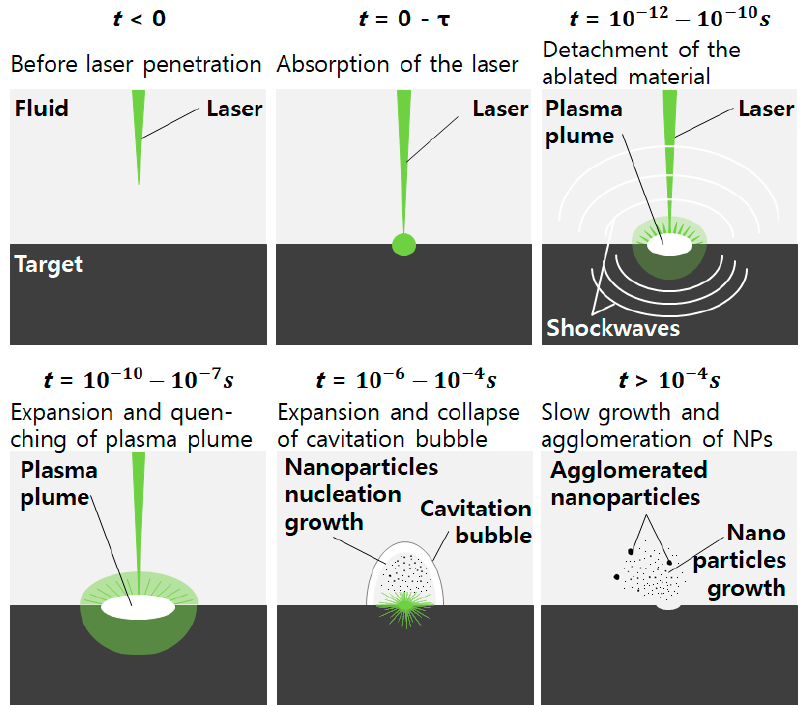
Figure 3. Rapid heating by a laser beam and subsequent plasma formation leads to the formation of cavitation bubbles, then vaporization by nanoparticle (NP) nucleation and growth in a pulsed laser, at t ~ 10 − 6 –10 − 4 s. (Modified from Stauss’ nanomaterial nucleation diagram [46]). Muneoka et al. described the following six stages in more detail: plasma formation (phase I), cavitation bubble expansion (phase II), bilayer cavitation bubble expansion (phase III), contraction (phase IV), stagnation (phase V), and cavitation bubble collapse with nanoparticle release (phase VI) [51]. Ibrahimkutty et al. observed the moments at 320 microseconds (phase VI) in which the bubble collapse after the rise of the plasma plume inside the cavitation bubble, as shown in Figure 4 by X-ray [50]. At that moment, the evaporation products are released into the